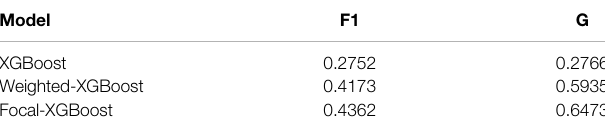
TABLE 6 | Comparison of prediction results of XGBoost series models. Model F1 G